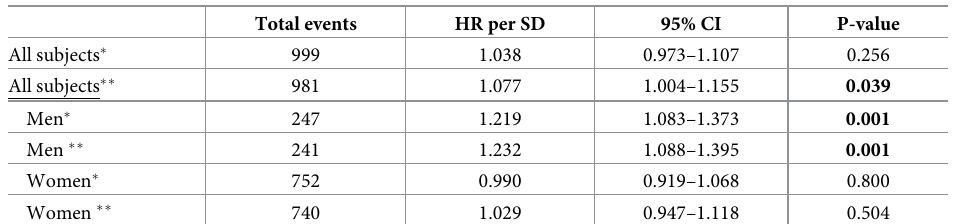
Table 3. The association between MR-pro-ADM and incident fractures.